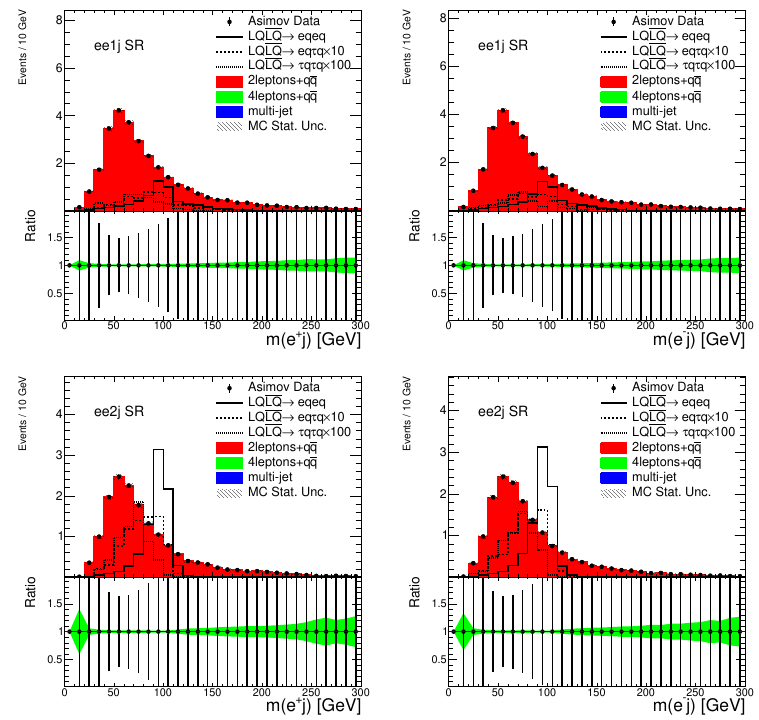
Figure 2 . The distribution of the invariant mass of a lepton candidate and a jet candidate in the signal region “ee1j” (top) and “ee2j” (bottom). The left one is m ( e + j ) and the right one is m ( e − j ) . The black points in the upper pads show the asimov data which is just the sum of all background events with uncertainties completely suppressed for better illustration. The ratio of the asimov data and the total background is shown in the lower pads, where the error bars on the black points represent the expected data uncertainty while the green bands represent the total MC statistical